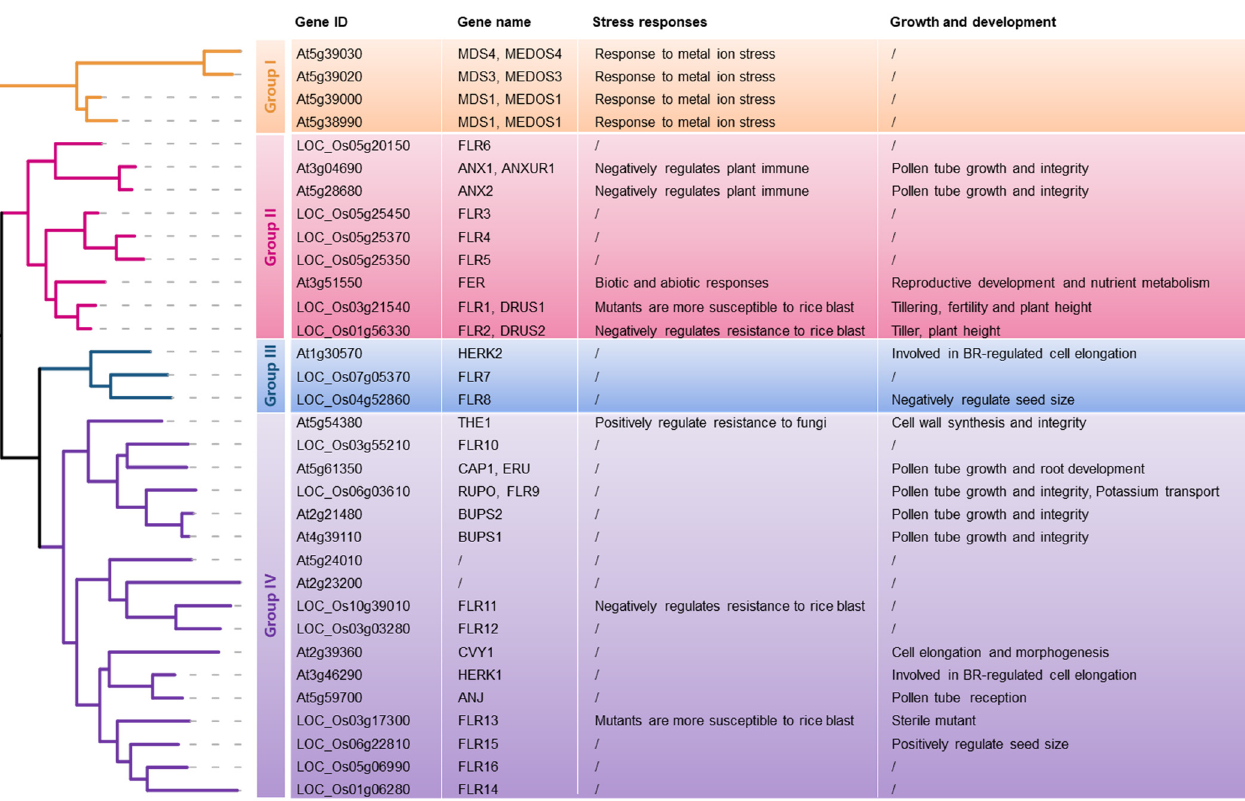
Figure 4. Phylogenetic tree of the CrRLK1L subfamily in Arabidopsis and rice. Phylogenetic tree of full-length amino acid sequences of the CrRLK1L subfamily in Arabidopsis and Oryza was constructed using MEGA 7.1 with the NJ method (all parameters were default values).